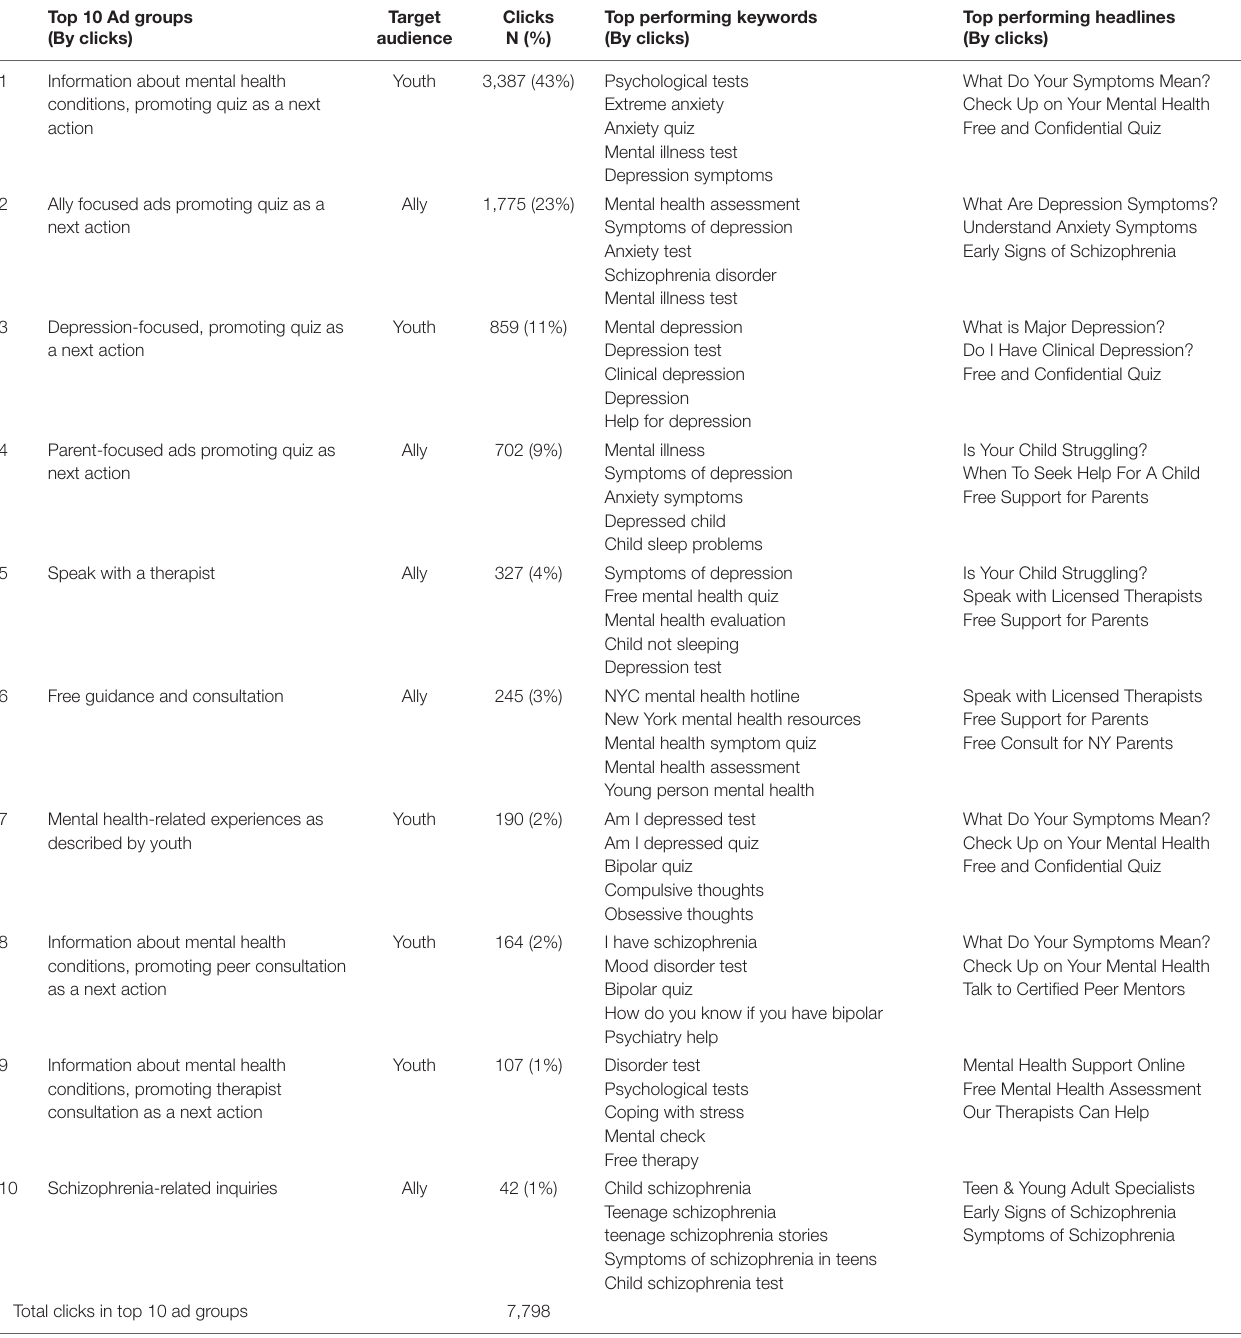
TABLE 1 | Top performing search engine ad content (by clicks). Top 10 Ad groups Target Clicks Top performing keywords Top performing headlines (By clicks) audience (By clicks) (By